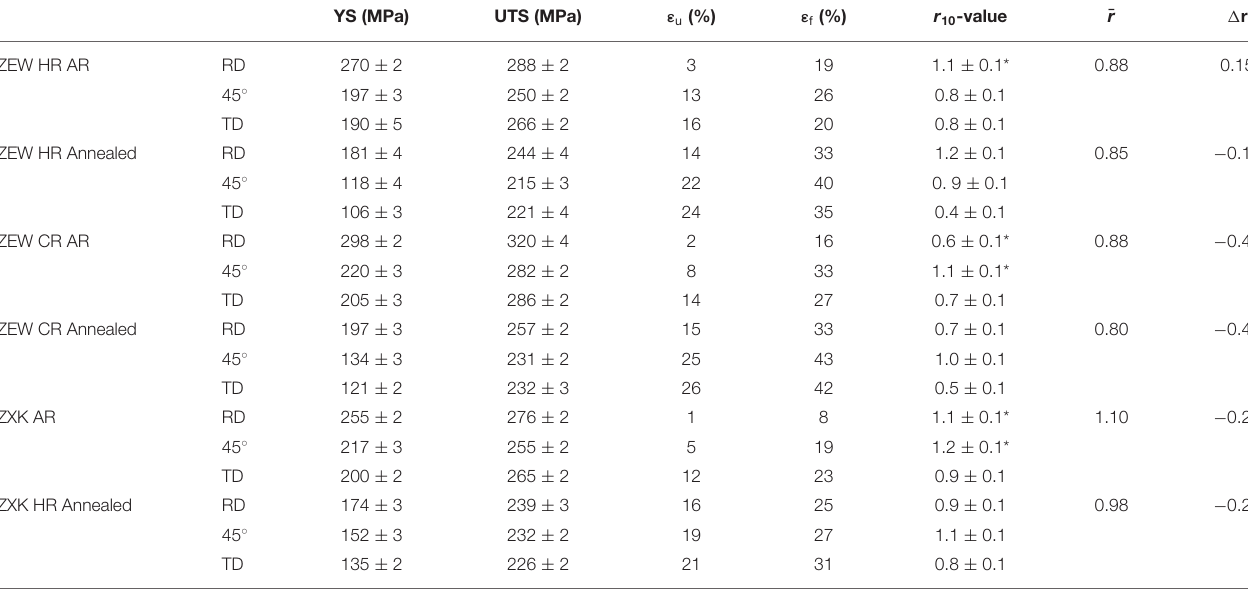
TABLE 1 | Tensile properties at room temperature of as-rolled and annealed samples tested along RD, 45 ◦ to RD and TD (YS, tensile 0.2% yield stress; UTS, ultimate tensile stress, ε u , uniform elongation; ε f , elongation to fracture, r 10 Lankford